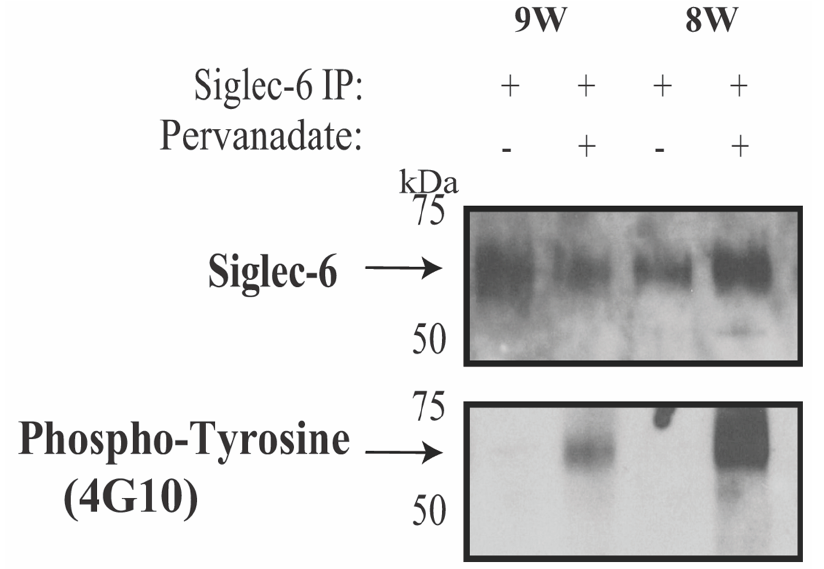
Figure 3. Siglec-6 undergoes Tyrosine Phosphorylation in First Trimester Human Placenta. First trimester human placental chorionic villus tissue (gestational age 8 and 9 weeks, 8W and 9W) was incubated with PBS alone or pervanadate. Tissue was then washed, pulverized, lysed, and immunoprecipitated with an anti-Siglec-6 antibody. The immunoprecipitates were analyzed by duplicate immunoblots probed with anti-Siglec-6 or anti-phosphotyrosine antibodies. A total of four human placental samples were used over two experiments with similar results.